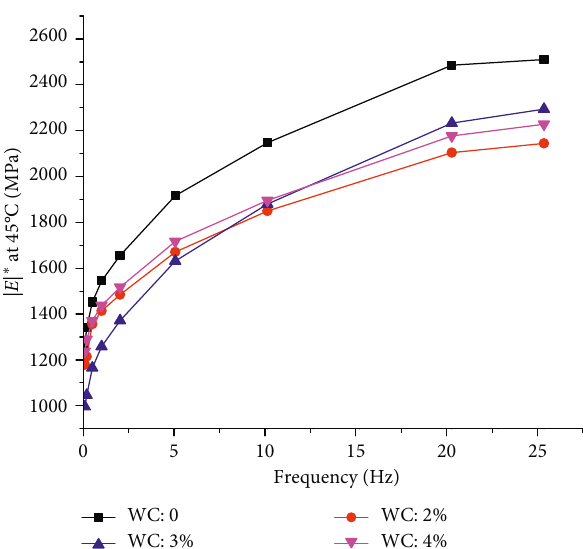
Figure 16: SBS#AC-13-type high-temperature dynamic modulus.